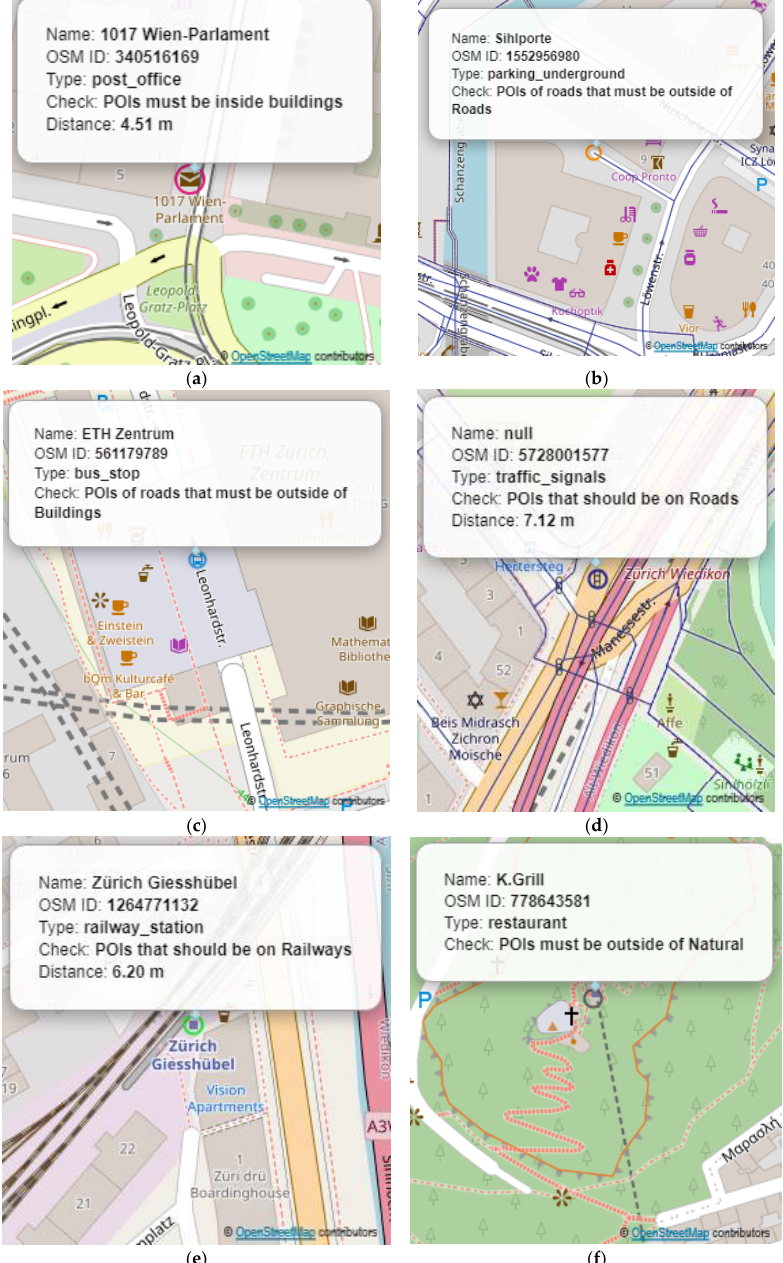
Figure 2. Topo-semantic checks. Check 1: “POIs must be inside buildings” ( a ); Check 2: “ POIs must be outside of roads” ( b ); Check 3: “POIs must be outside of buildings” ( c ); Check 4: “POIs must be on roads” ( d ); Check 5: “POIs must be outside of nature” ( e ); Check 6: “POIs must be on railways” ( f